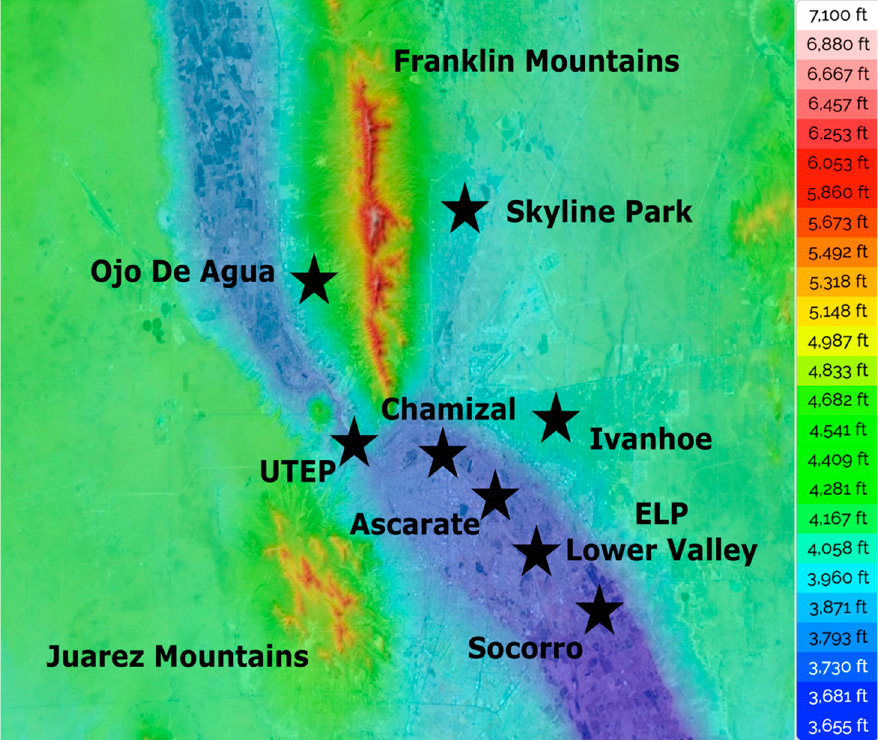
Figure 1. Complex orography of the EPJ region showing apparent elevations in the downtown part and along the banks of the Rio Grande River and the surroundings. Location of Continuous Ambi- ent Air Monitoring Stations (CAMS) operated by the Texas Commission on Environmental Quality (TCEQ): CAMS 12 (UTEP), 41 (Chamizal), 37 (Ascarate), 36 (El Paso Lower Valley), 49 (Socorro), 414 (Ivanhoe), 72 (Skyline) and 1021 (Ojo De